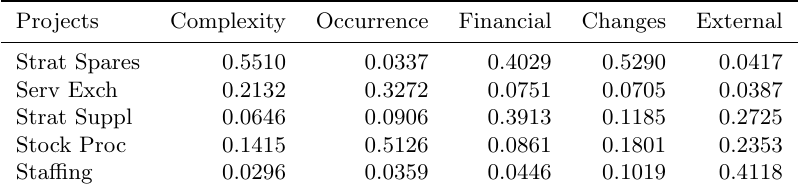
Table 4: Audit project risk